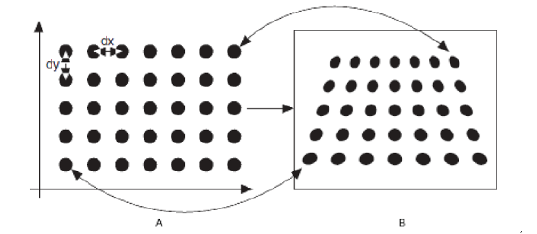
Figure 7. NIVisionCalibrationProcessforOverHeadCameraVideo Tracking System